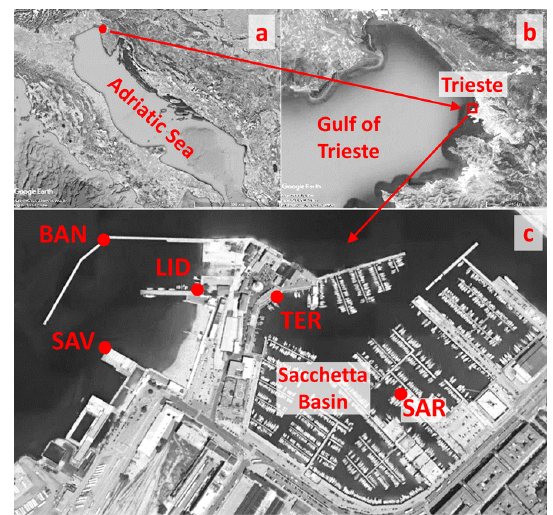
Figure 1. Aerial image of the area of Trieste harbour with the ob- servation sites: Molo Sartorio (SAR), Molo Santa Teresa (TER), Bagno Savoia (SAV), Porto Lido (LID) and Molo Bandiera (BAN). (Images extracted from Google Earth; ©2018 Landsat/Copernicus, ©2018 CNES/Airbus, ©2018 Digital Globe, ©2018